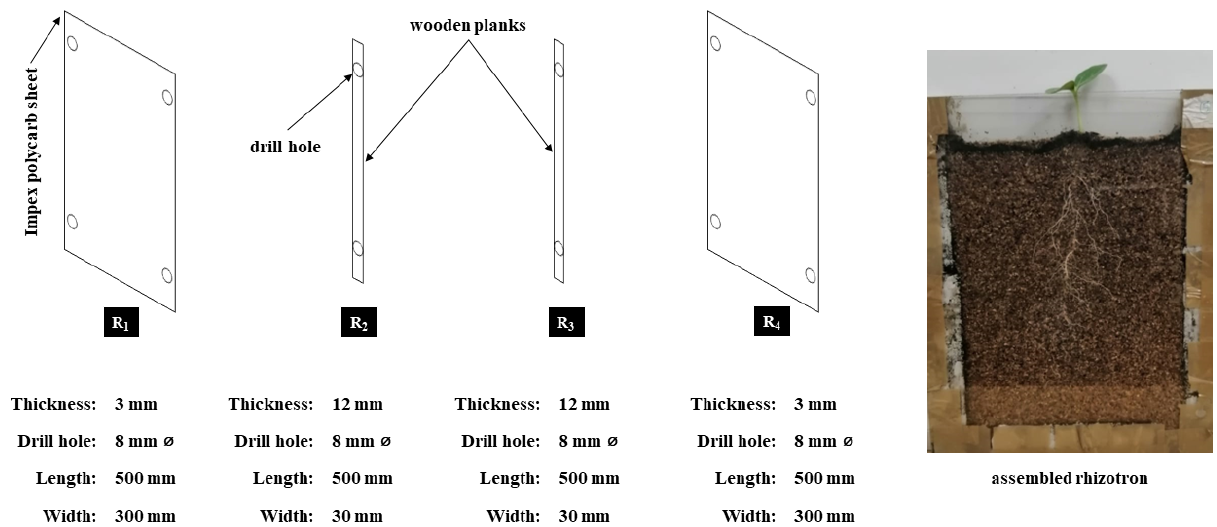
Figure 7. Sketch of an inexpensive rhizotron design assembly — observations of the root systems are taken on the lateral sides of the rhizotrons.